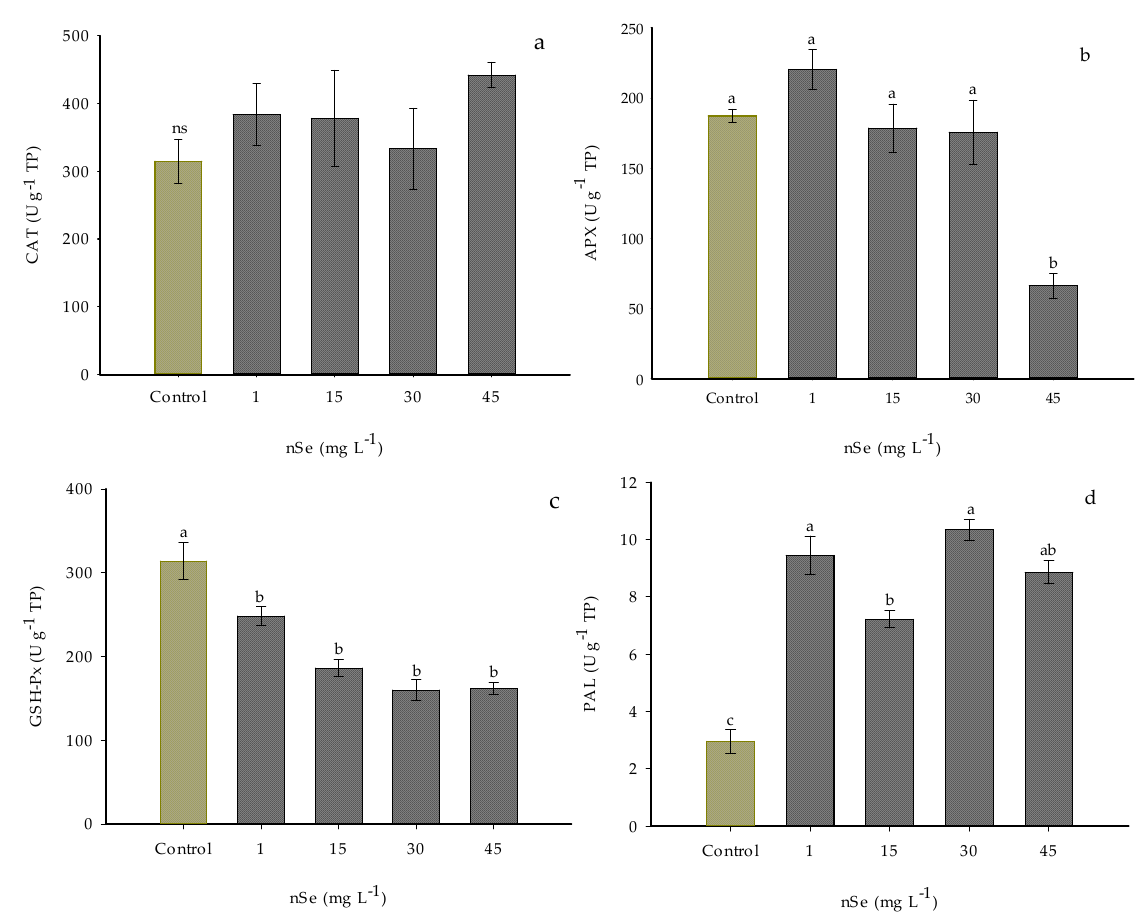
Figure 5. Enzyme activity in Jalapeño pepper fruits with nSe. ( a ) CAT; ( b ) APX; ( c ) GSH-Px; ( d ) PAL; ns: not significant between treatments; TP: total proteins. Different letters indicate differences between treatments (Tukey test p ≤ 0.05). n = 5 ± standard error.